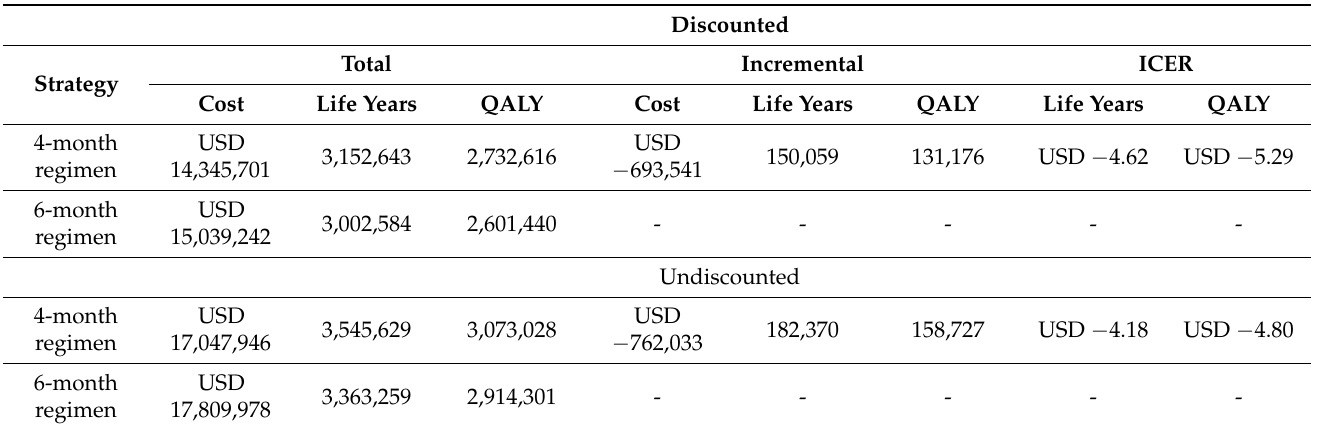
Table 2. Incremental cost-effectiveness of the 4-month as compared to the 6-month shortened TB treatment